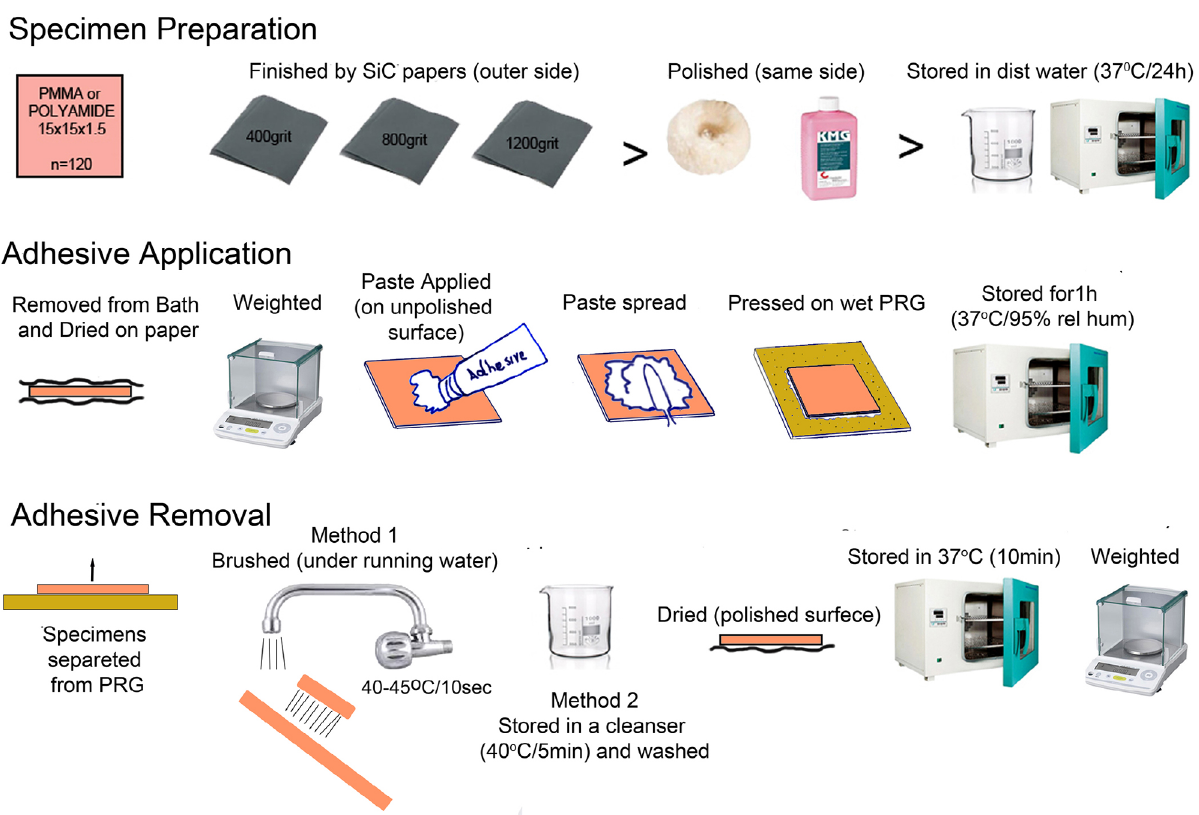
Figure 2- Schematic representation of the weighting methodology process, divided in three distinct phases. Specimen preparation, adhesive application and adhesive removal (PRB is for polysulfide rubber